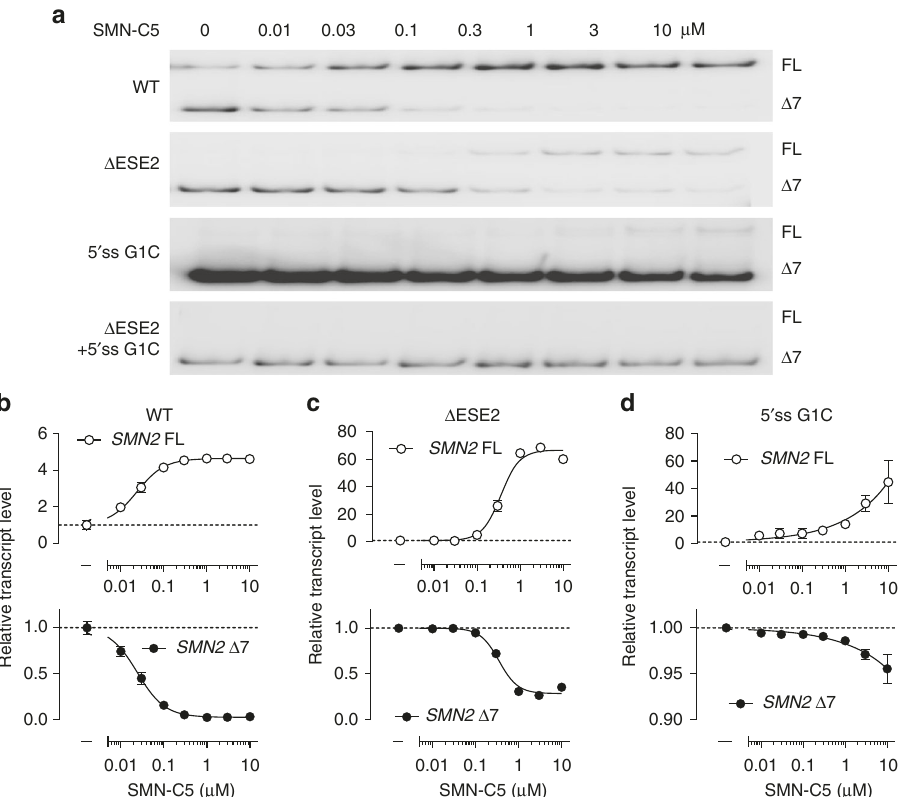
Fig. 5 Requirement of both 5 ′ ss and ESE2 mutation/deletion for full abolishment of SMN-C5 activity. a Cell-based splicing assay of SMN2 minigene constructs in HEK293 cells treated with increasing concentrations of SMN-C5 (0.01 – 10 µ M) in wild-type constructs and in constructs harboring a 5 ′ ss mutation (G1C), a deletion of the ESE2 region ( Δ ESE2) or both 5 ′ ss G1C and Δ ESE2. In the double-mutant construct ( Δ ESE2 + 5 ′ ss G1C), the SMN-C5 effect was completely abolished. Full blots shown in Supplementary Fig. 8. b , c , d Quantitative assessment of the data by RT-qPCR. b Wild-type (WT),